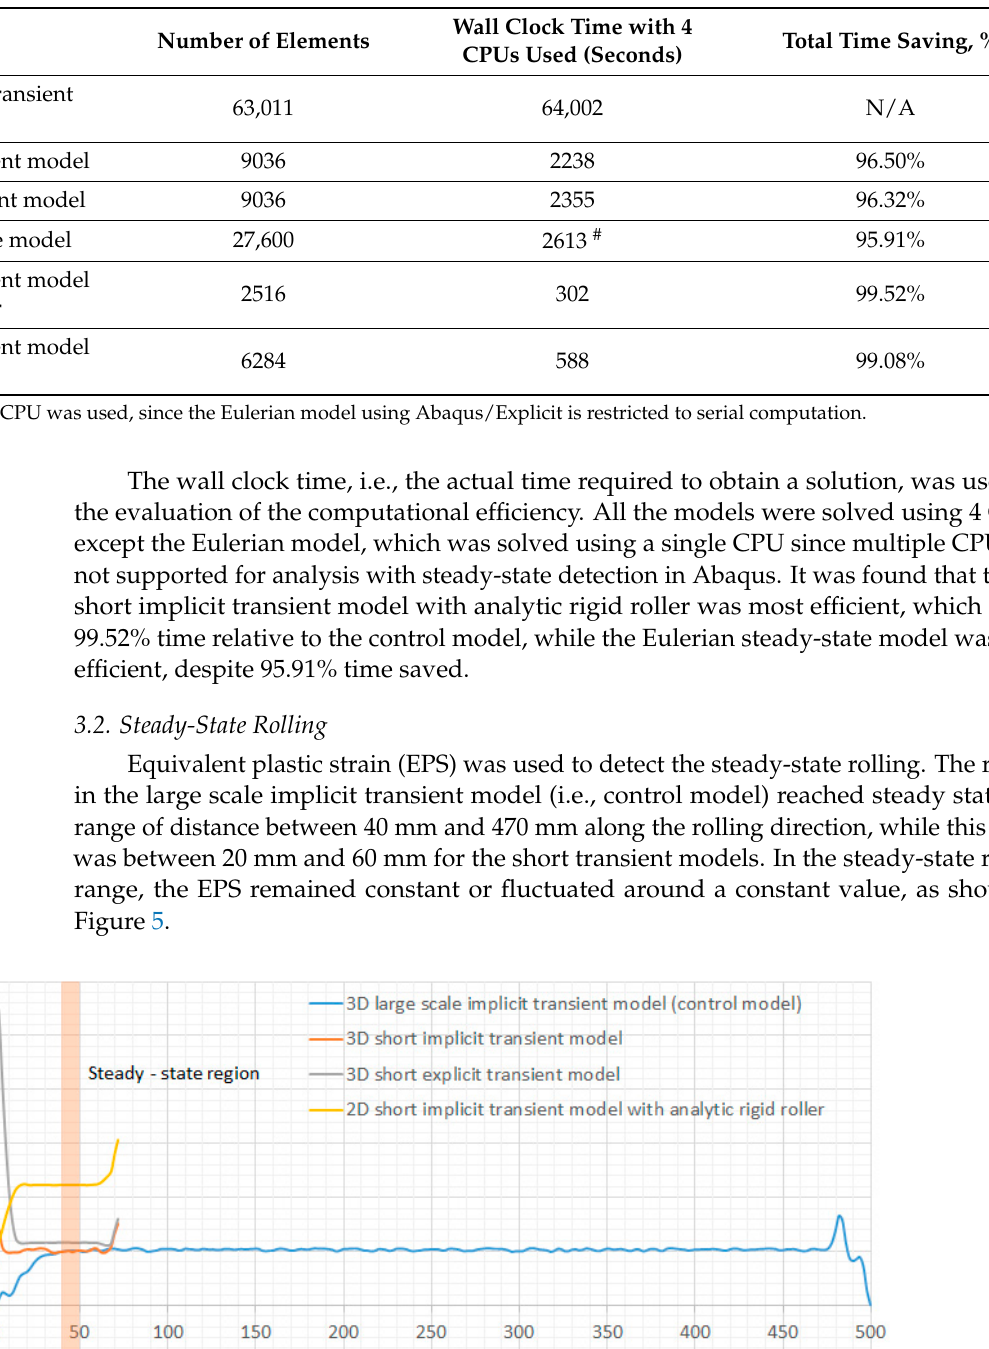
Table 1. Comparison of computational efficiency between different models.